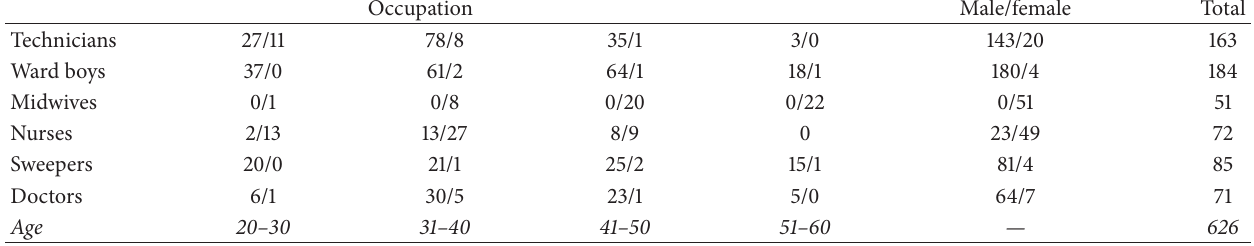
Table 1: Gender-, occupation-, and agewise distribution of the sample population.